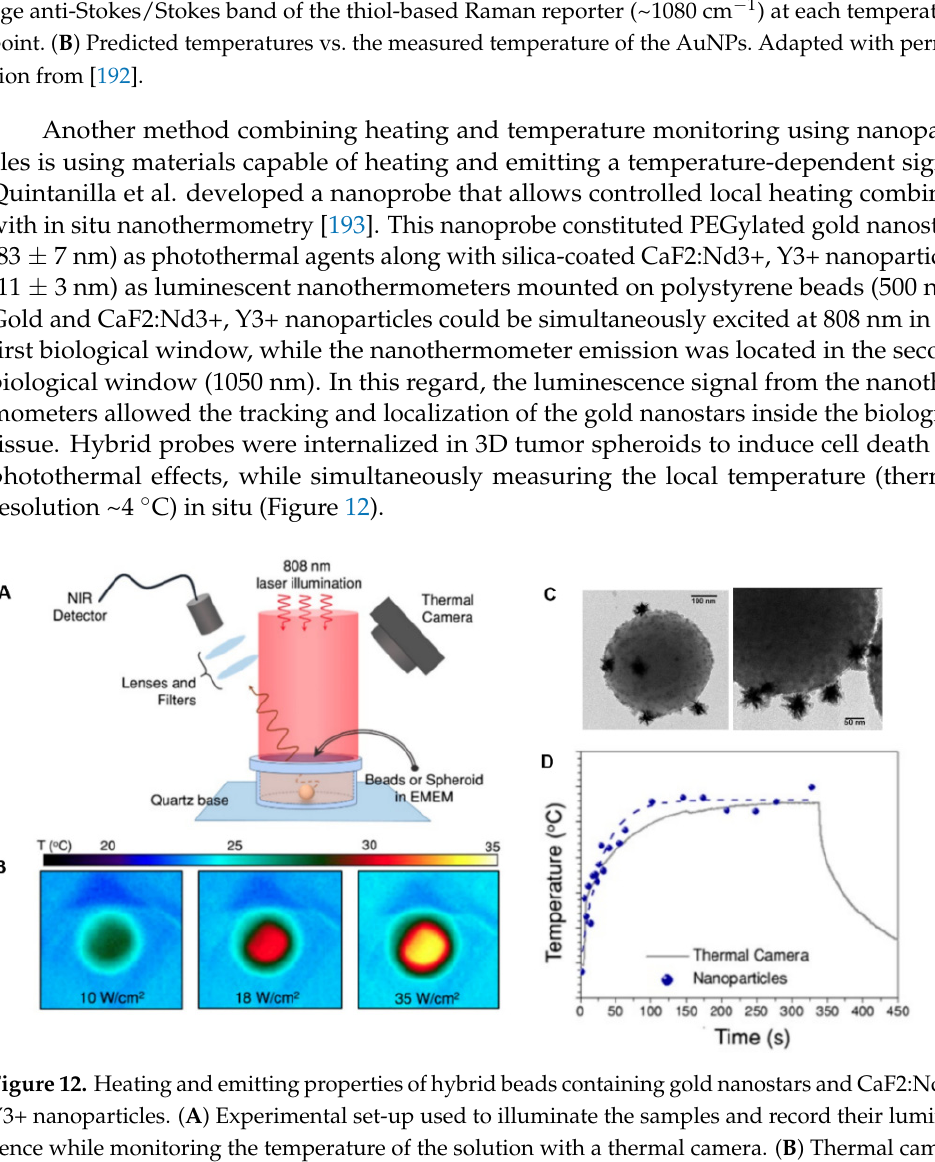
Figure 11. Model of heating AuNPs (25–42 °C) buried in 10 mm porcine tissue. ( A ) The average anti- Stokes/Stokes band of the thiol-based Raman reporter (~1080 cm − 1 ) at each temperature point. ( B ) Predicted temperatures vs. the measured temperature of the AuNPs. Adapted with permission from [192].